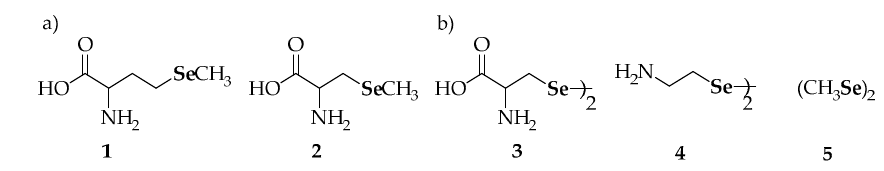
Figure 1. Naturally occurring selenides ( a ) and diselenides ( b ).